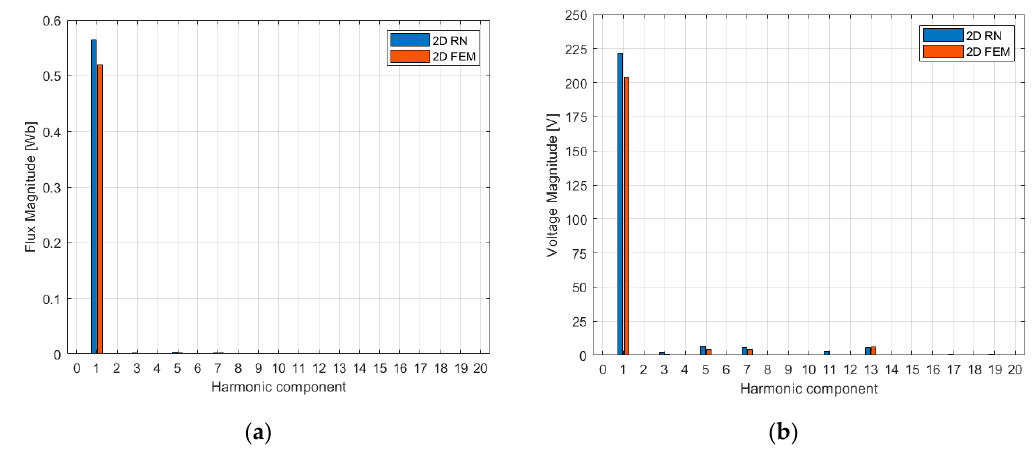
Figure 14. Frequency spectrum analysis of the results: ( a ) frequency spectrum of the magnetic flux curves generated by the 2D RN and 2D FEM; ( b ) frequency spectrum of the EMF curves generated by the 2D RN and 2D FEM.